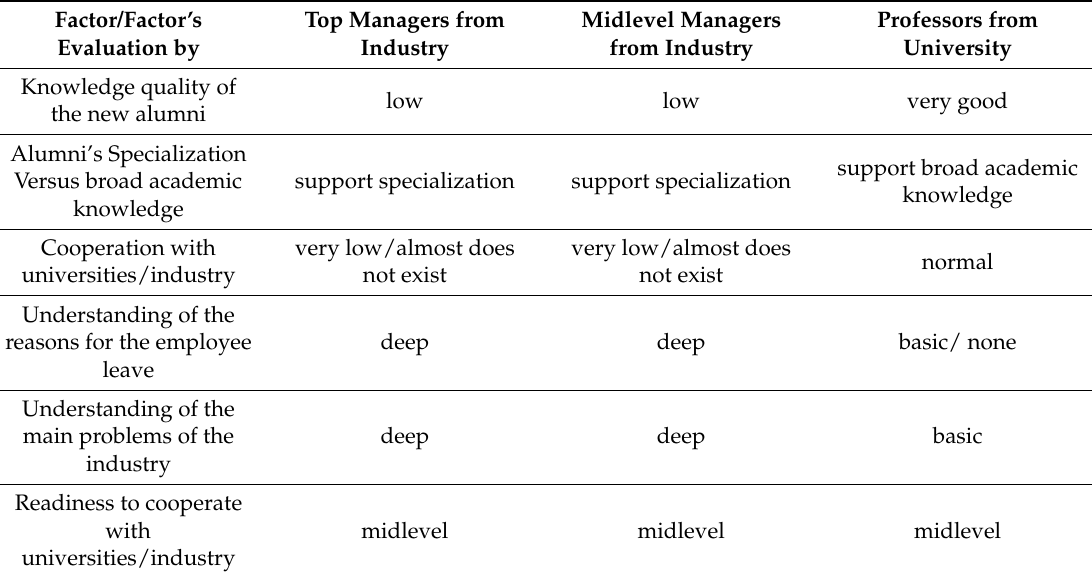
Table 5. Evaluation of the actual factors by industry and university